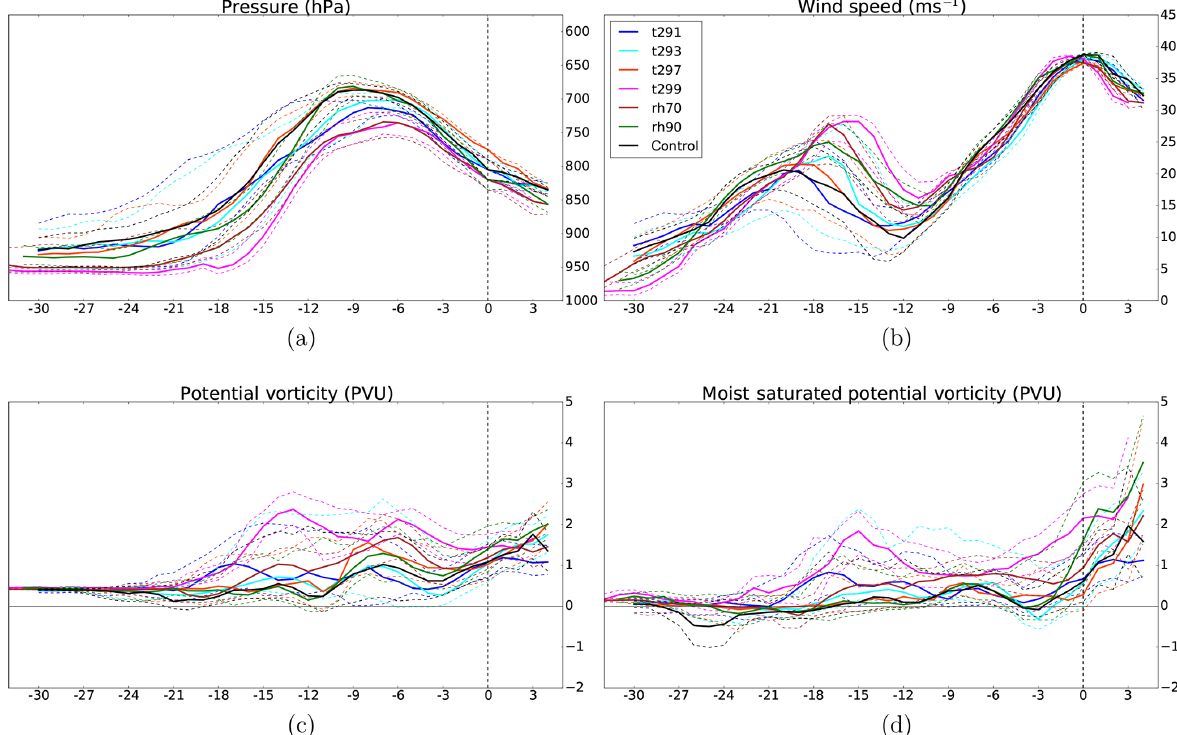
Figure 11. As in Fig. 10 but for the control simulation and for the runs with modified initial relative humidity (rh70, rh90) and initial temperature (t291, t293, t297,